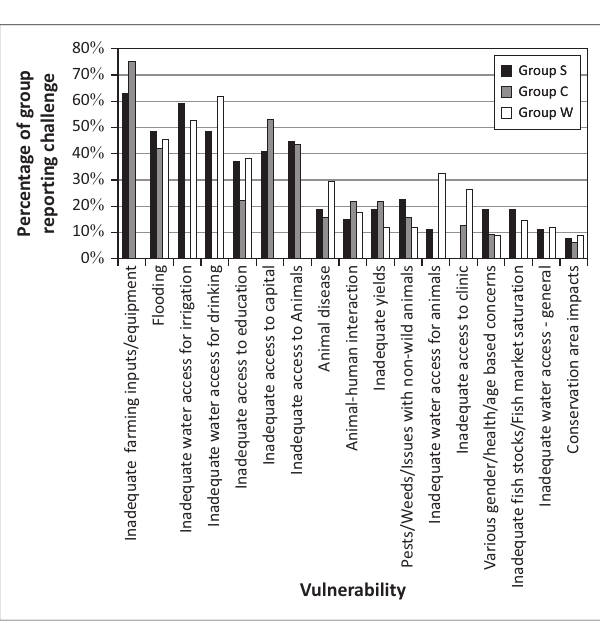
FIGURE 10: The different assemblages of vulnerability for the three groups in